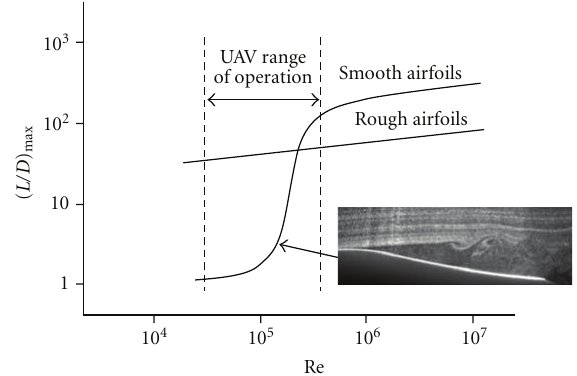
Figure 3: Lift-to-drag ratio variation with Reynolds number, reproduced from